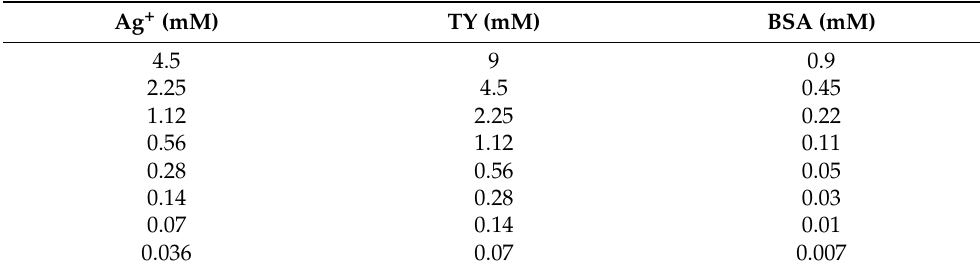
Table 4. Concentration of silver, TY and BSA in complexes with TY or with